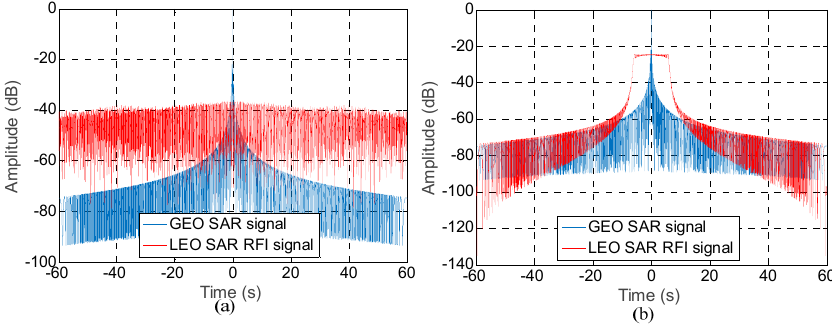
Figure 9. GEO SAR and LEO SAR RFI signals after Doppler filtering: ( a ) about 300 Hz/s 2 Doppler rate difference; ( b ) about 0.024 Hz/s 2 Doppler rate difference.